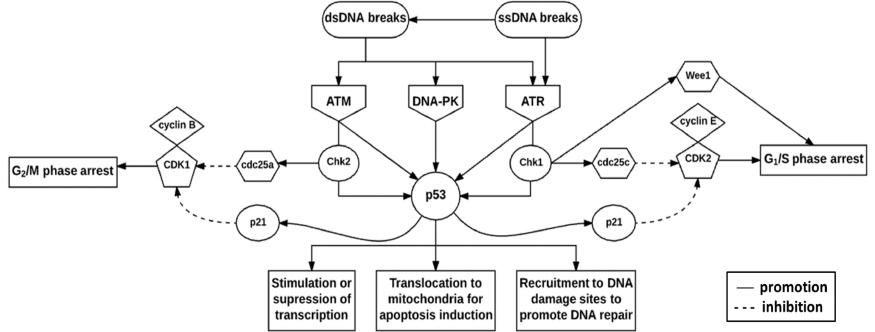
Figure 2. Deoxyribonucleic acid damage checkpoint complex. DNA damage presenting as double-strand DNA (dsDNA)- or single-strand DNA (ssDNA) breaks initiate the DNA damage response (DDR) via ataxia telangiectasia mutated (ATM), DNA-dependent protein kinase (DNA-PK) and ataxia telangiectasia and rad3-related protein (ATR). Checkpoint kinase 2 (Chk2) is expressed throughout the cell cycle and is activated by ATM, whereas checkpoint kinase 1 (Chk1) expression is restricted to the G 1 - and S phases and is activated by ATR. These checkpoint kinases phosphorylate and subsequently activate p53 which integrates stress signals to determine the fate of the cell.